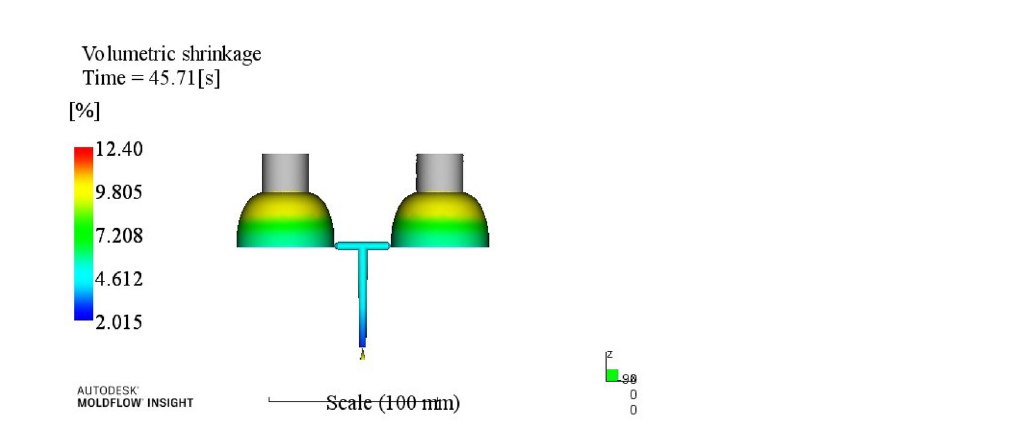
Figure 9. The simulation results of the Volume shrinkage.